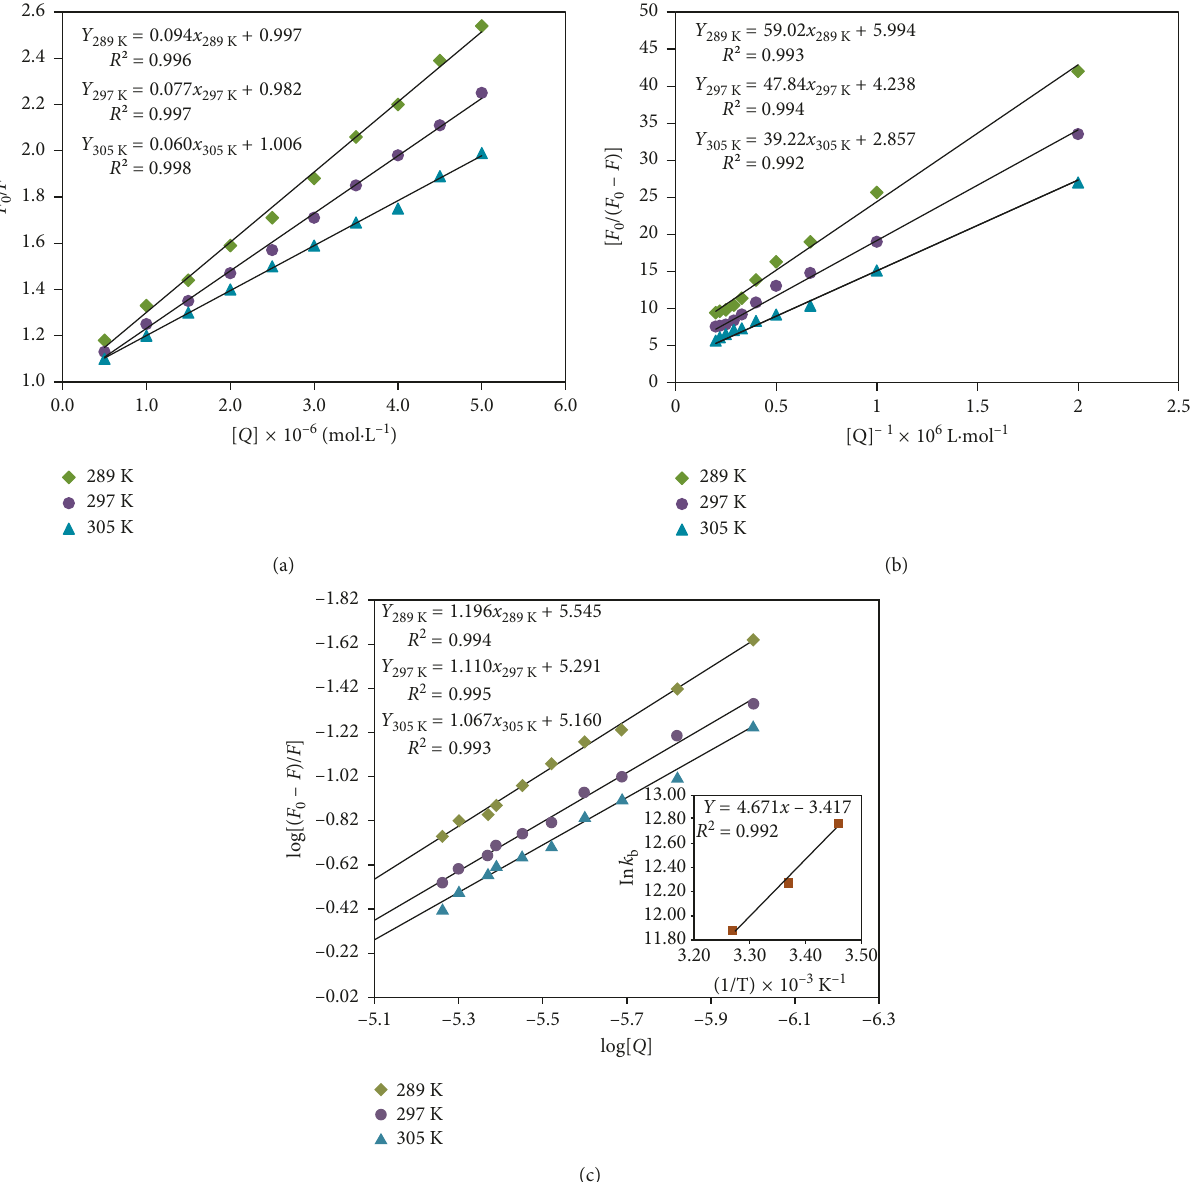
− F ) /F ] versus log [ Q ] (the inset of (c) is van ’t Hoff 0